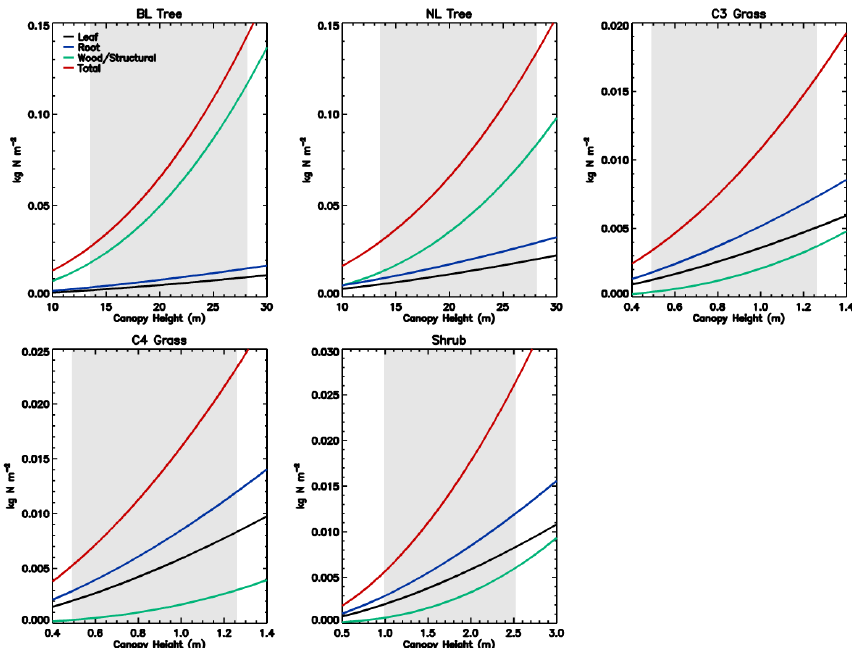
Figure 2. Total vegetation N along with N pools of leaf, root, and wood as a function of canopy height for individual PFTs at full leaf. The grey region shows the defined range of canopy height within the model. Note that both the x and y scales are very different for each